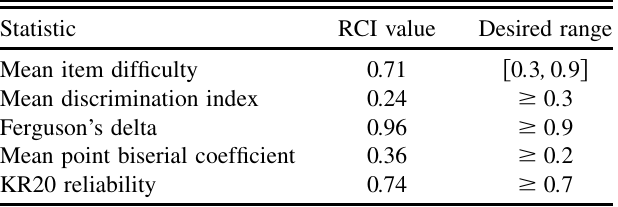
TABLE II. RCI post-test statistics. Sample size N ¼ 63 stu- dents. The desired ranges are those suggested by Ding and Beichner